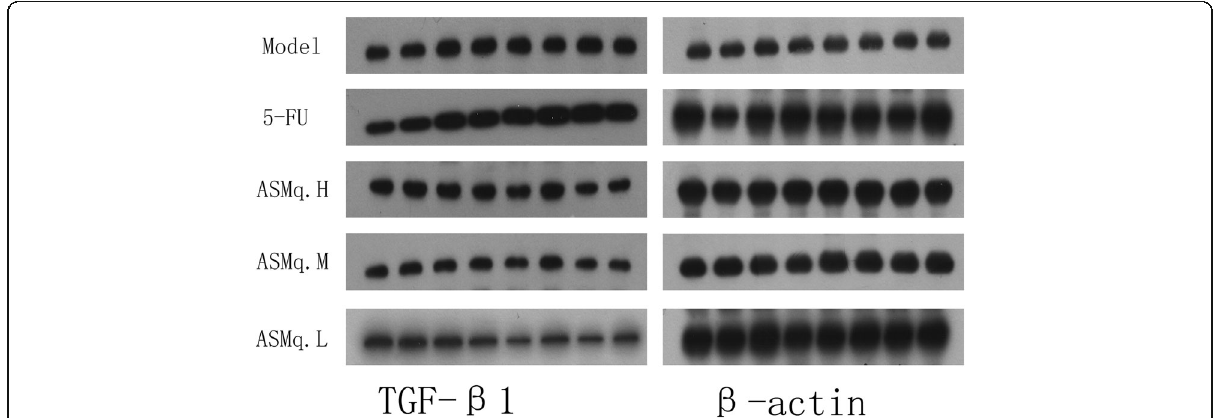
Fig. 4 The effects of 5-FU combined with Abnormal Savda Munziq on the protein expression of TGF- β 1 in mice bearing U27 cell-induced